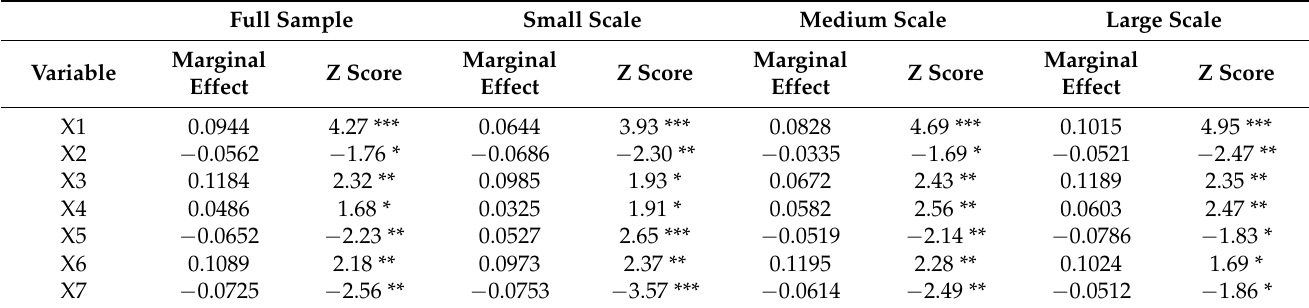
Table 5. Marginal effects of factors affecting the production efficiency based on different farm